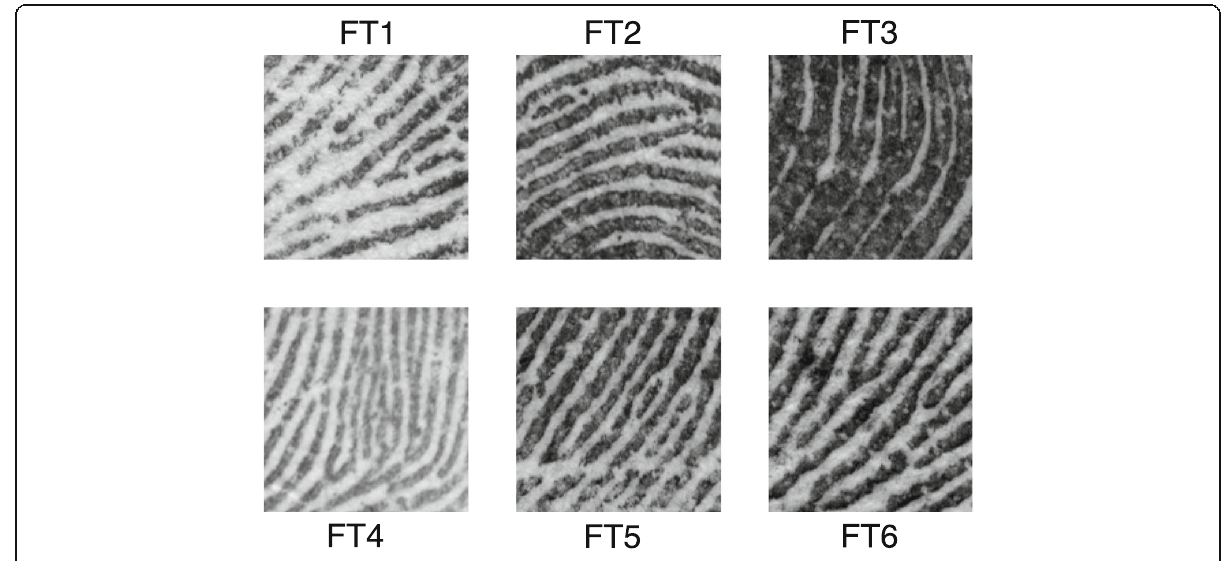
Fig. 8 Images used in Cropped tasks from image sets FT1 –